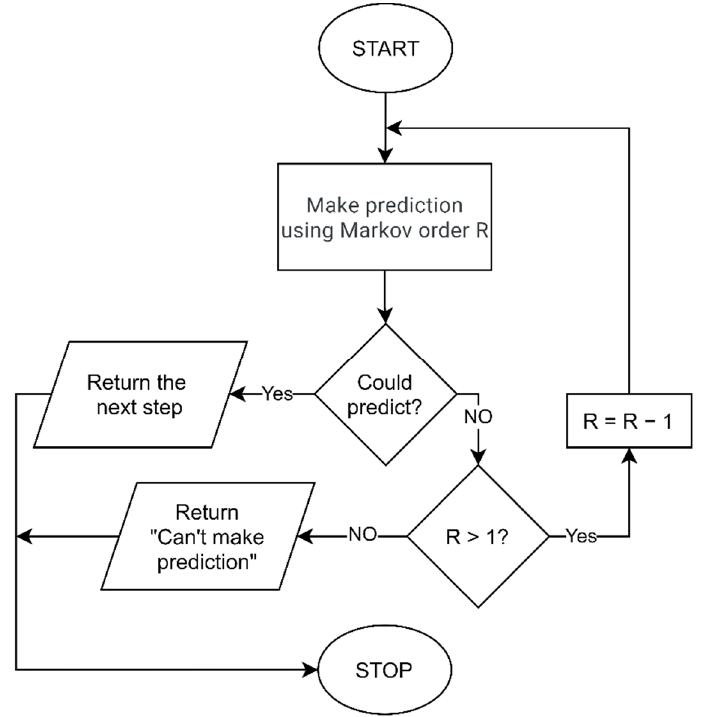
Figure 6. Prediction flowchart for PPM.